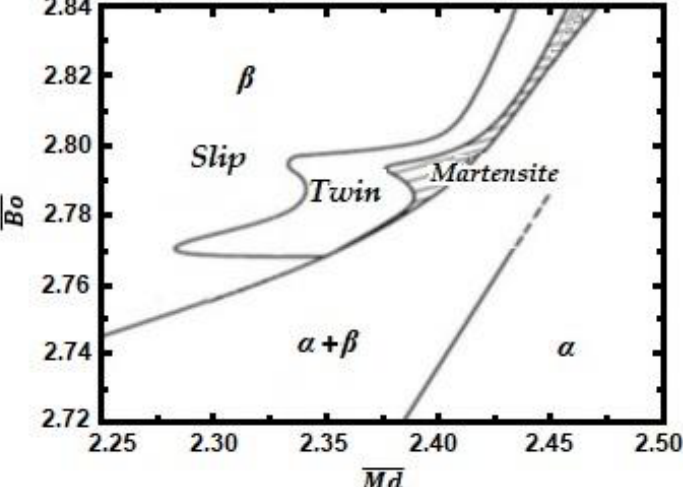
Figure 1. The 𝐵𝑜 ̅̅̅ and 𝑀𝑑 ̅̅̅̅ stability-phase map, showing the positions of the designed alloys [38,39].